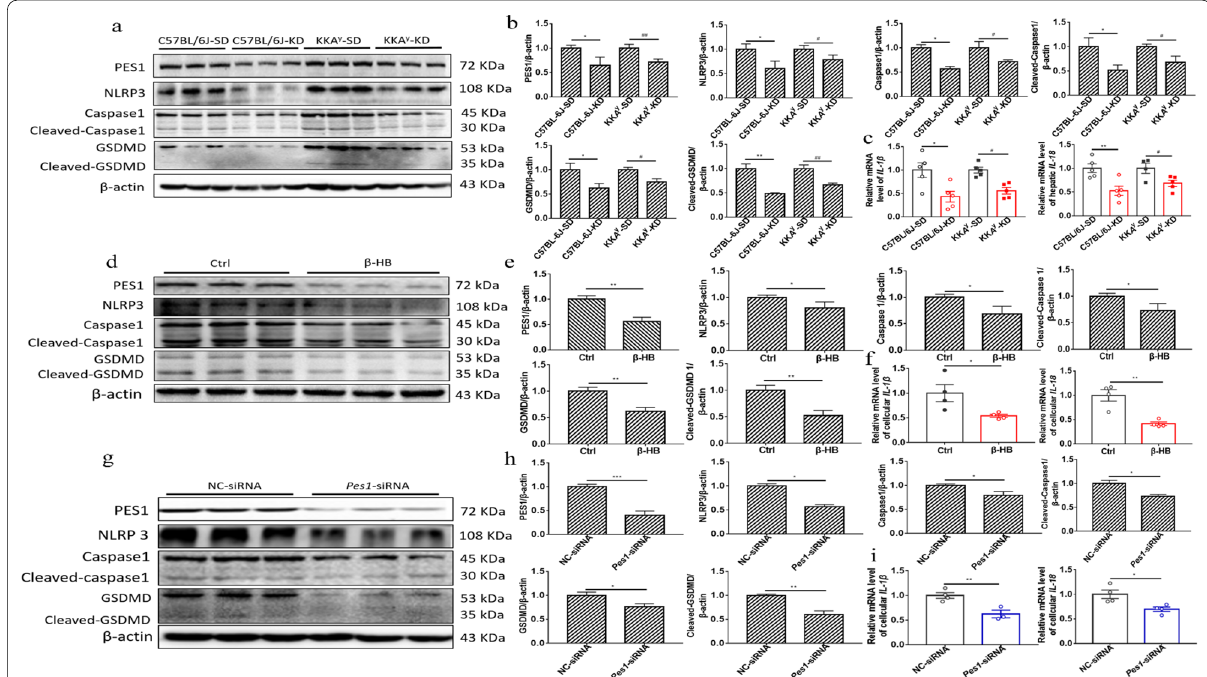
Fig. 7 KD feeding and β-HB treatment decreased inflammation responses by downregulating PES1. a , b KD feeding in normal and diabetic mice suppressed the inflammation related proteins. c Relative mRNA levels of hepatic IL-1β and IL-18 were measured by qRT-PCR. d , e β-HB treatment in hepatocytes inhibited the inflammation proteins. f Relative mRNA levels of IL-1β and IL-18 in cultured hepatocytes were measured by qRT-PCR. g , h Pes1 knockdown in hepatocytes lowered the inflammation proteins. i Shown are the effects of Pes1 knockdown on the relative mRNA levels of cellular IL-1β and IL-18 . j , k Pes1 supplementation in hepatocytes enhanced the levels of inflammation proteins. l Exhibited are the effects of Pes1 supplementation on the relative mRNA levels of cellular IL-1β and IL-18 . m , n Pes1 -CKO in mice reduced inflammation proteins in murine livers. o Demonstrated are the effects of Pes1 knockout on the relative mRNA levels of hepatic IL-1β and IL-18 . Data were shown as mean each experiment performed independently 3 times. *P < 0.05, **P < 0.01, ***P < 0.001 compared with controls or # P < 0.05, ## P < 0.01, ### P < 0.001 compared with controls (Student’s t-test or ANOVA, Student–Newman–Keuls q